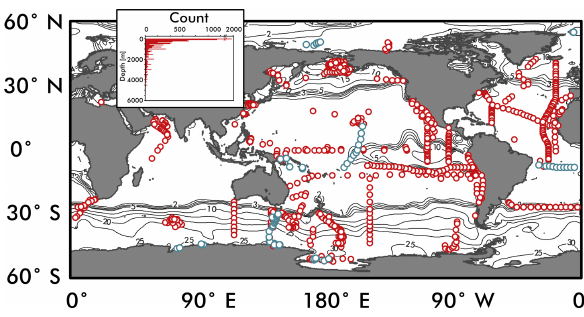
Figure 2. The location of global nitrate δ 15 N observations used to constrain the ensemble of artificial neural networks are shown as red circles. Observations used as an “external validation dataset” (those withheld from training the EANN) are shown in blue. Inset figure shows the number of observations versus depth. Contours are surface nitrate concentrations for October–December from World Ocean Atlas (Garcia et al.,